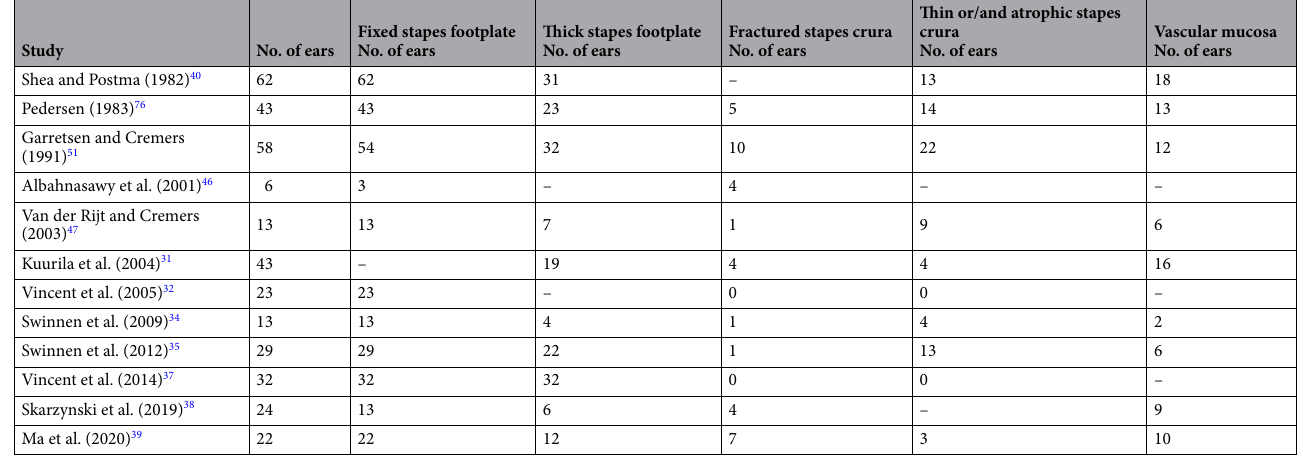
Table 3. Middle ear complications in individuals with osteogenesis imperfecta that underwent stapes surgery. Fixed and thick stapes footplates, crura fractures, thin and atrophic stapes, and vascular mucosa were among the most complications reported during stapes surgery in the OI